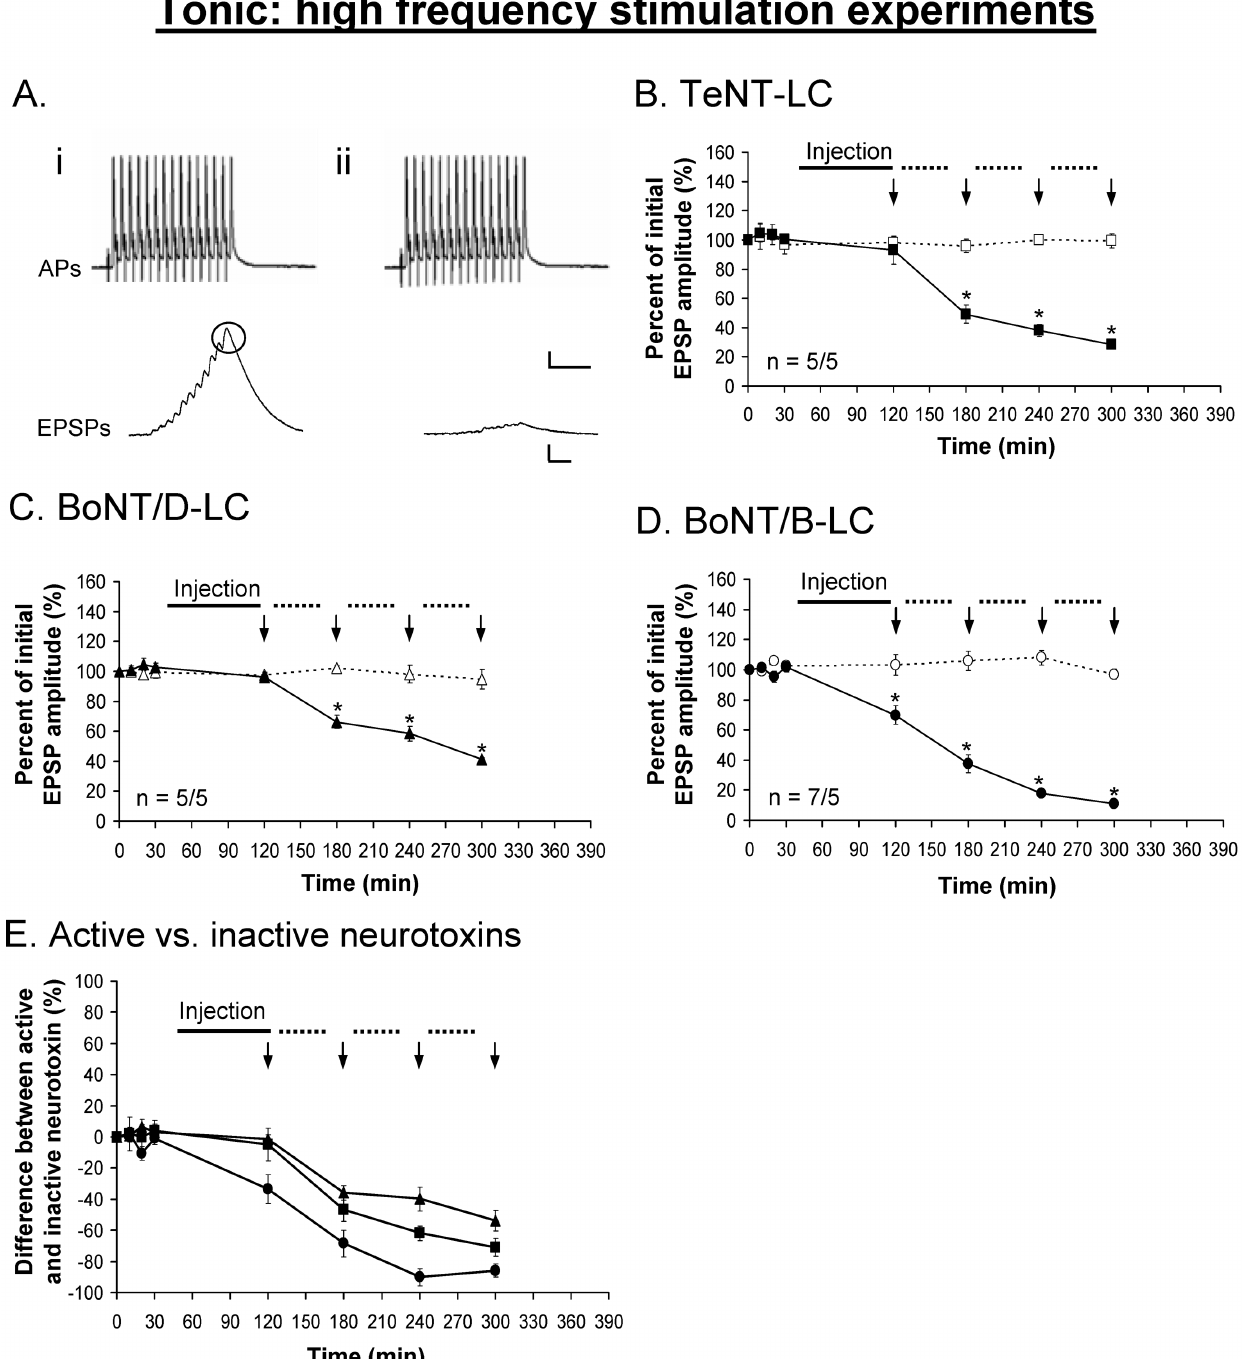
Figure 7. Tonic EPSPs are inhibited using TeNT-LC ( B ), BoNT/D-LC ( C ) and BoNT/B-LC ( D ) under high frequency stimulation. A , Example showing the tonic action potentials (APs) remain unchanged before ( i ) and after ( ii ) the injection of each neurotoxin (BoNT/B-LC used as the example). E , Percent difference between active and inactive neurotoxin, in which the inactive neurotoxin is the reference point at 0%. In B-E, a solid black line represents the time course of neurotoxin injection (90 min), the dotted lines represent the time course of each round of high frequency N stimulation (40 min) and vertical arrows ( Q ) represent when EPSPs were recorded. Active neurotoxins: TeNT-LC ( & ), BoNT/D-LC ( m ) and BoNT/B-LC ). Inactive neurotoxins: TeNT-LC ( % ), BoNT/D-LC ( g ) and BoNT/B-LC ( # ). Error bars represent S.E.M. The measured tonic (last) EPSP is encircled in ( black. An asterisk (*) denotes a significant difference (p , 0.05) and ‘n’ represents sample size (active/inactive neurotoxin). Scale bars: horizontal – 10 ms; vertical – 10 mV (AP), 5 mV (EPSP).